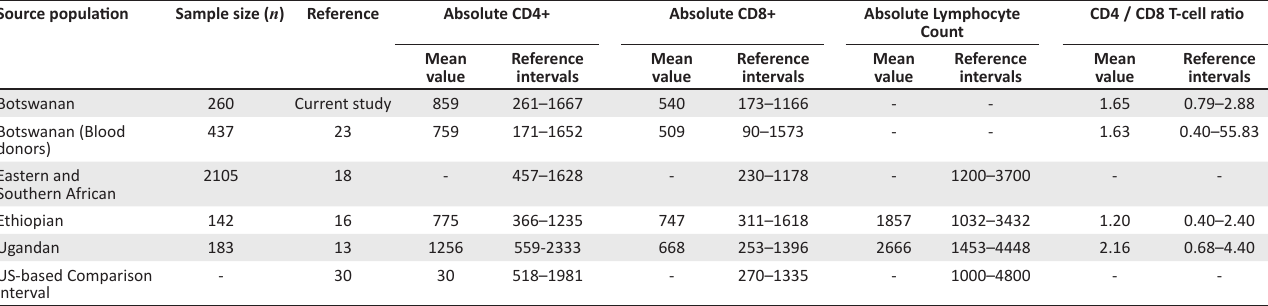
TABLE 4 : Comparison of ratio of CD4+ to CD8+ and absolute CD4+, CD8+ and lymphocyte counts between different populations. Source